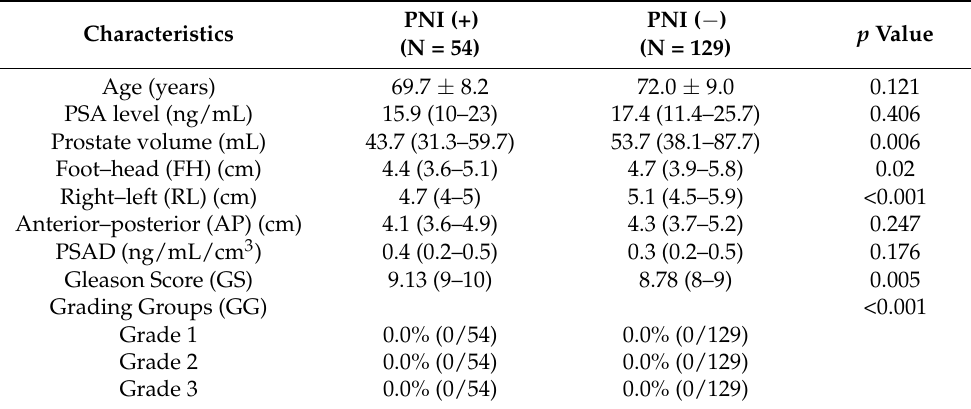
Table 1. Patient clinic radiological characteristics between groups of PNI (+) and PNI ( −